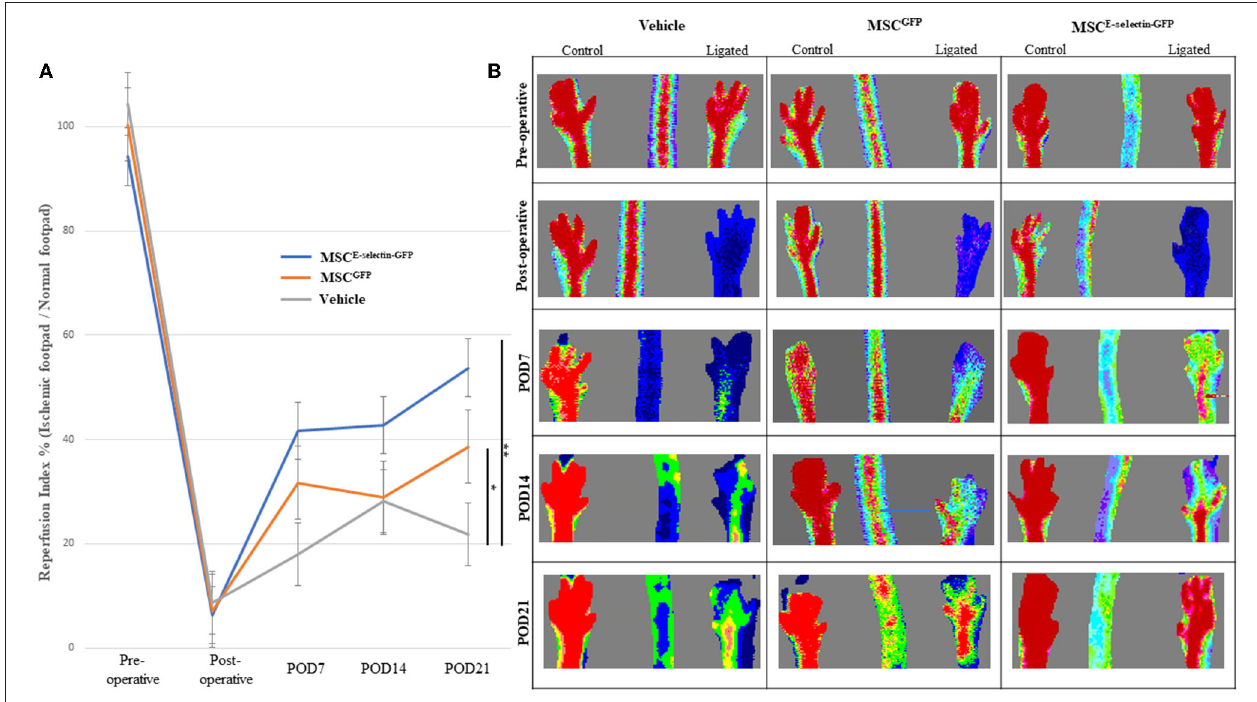
Table listing full name of upregulated genes with the † mark indicating the genes also upregulated in vivo within the ischemic tissue injected with supercharged MSC E − selectin − GFP vs. the ischemic tissue injected with control MSC GFP .